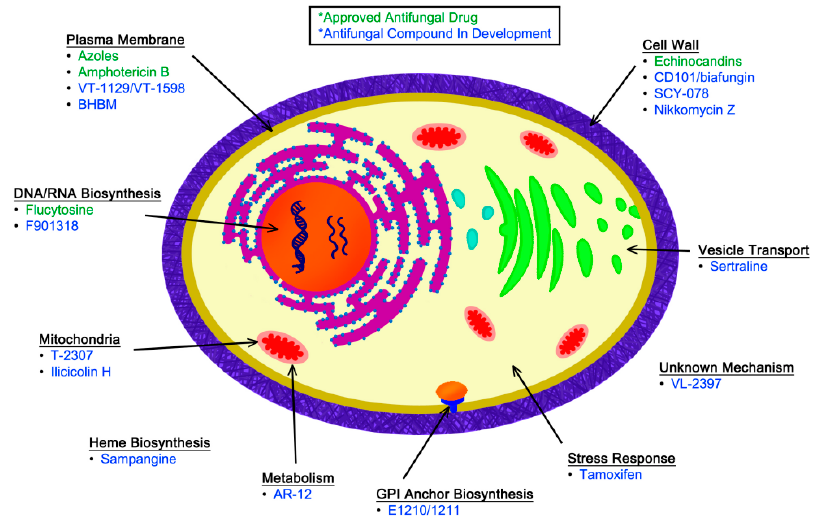
Figure 1. This diagram of a fungal cell indicates the sites of action for currently approved antifungal drugs (green) as well as other agents in various stages of development (blue).